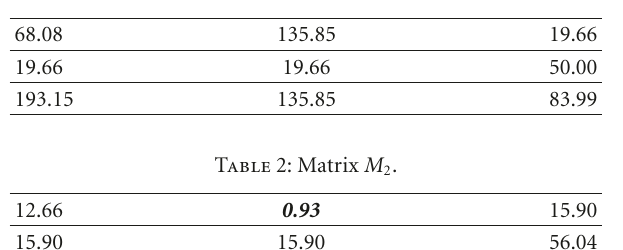
Table 1: Matrix M 1 .